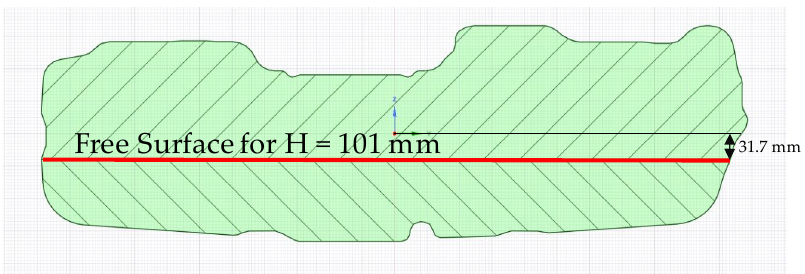
Figure 7. Free surface for the liquid level of 101 mm.